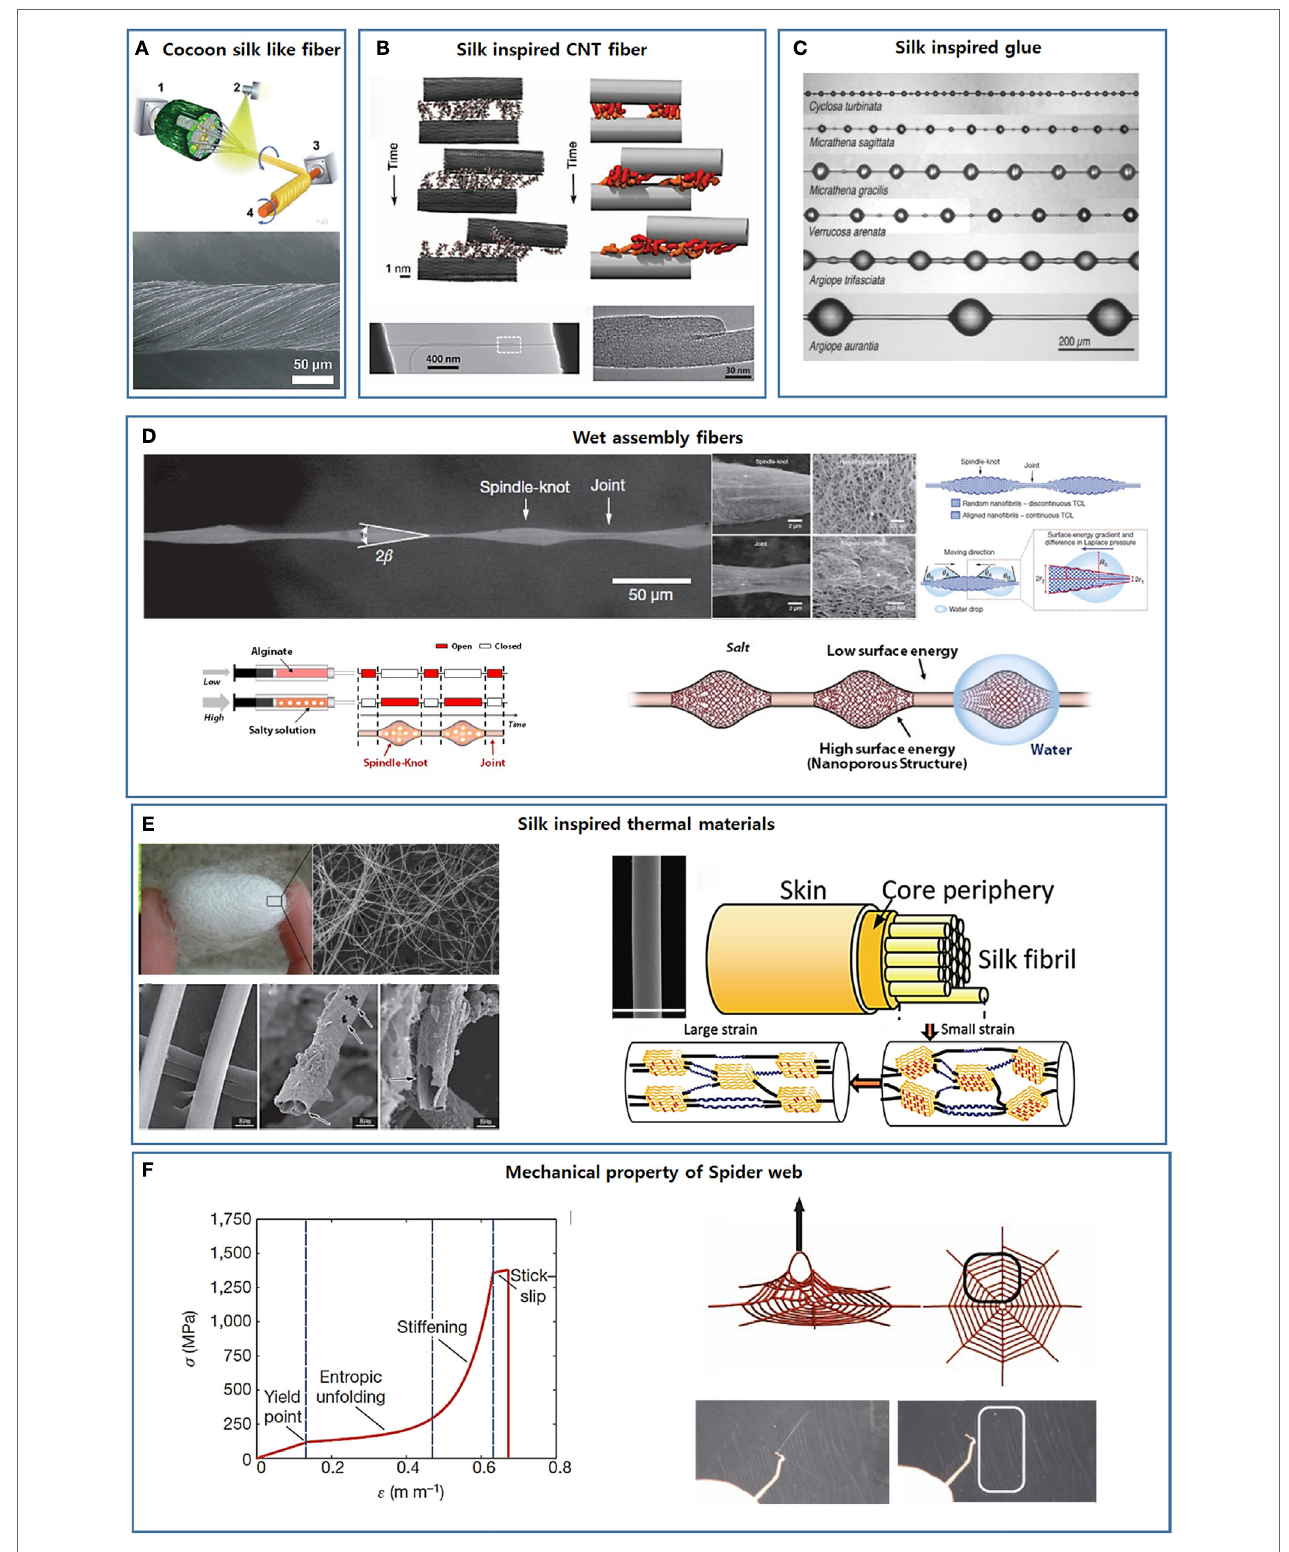
FiGURe 4 | Development of new smart materials by mimicking silk’s complex hierarchical structure.